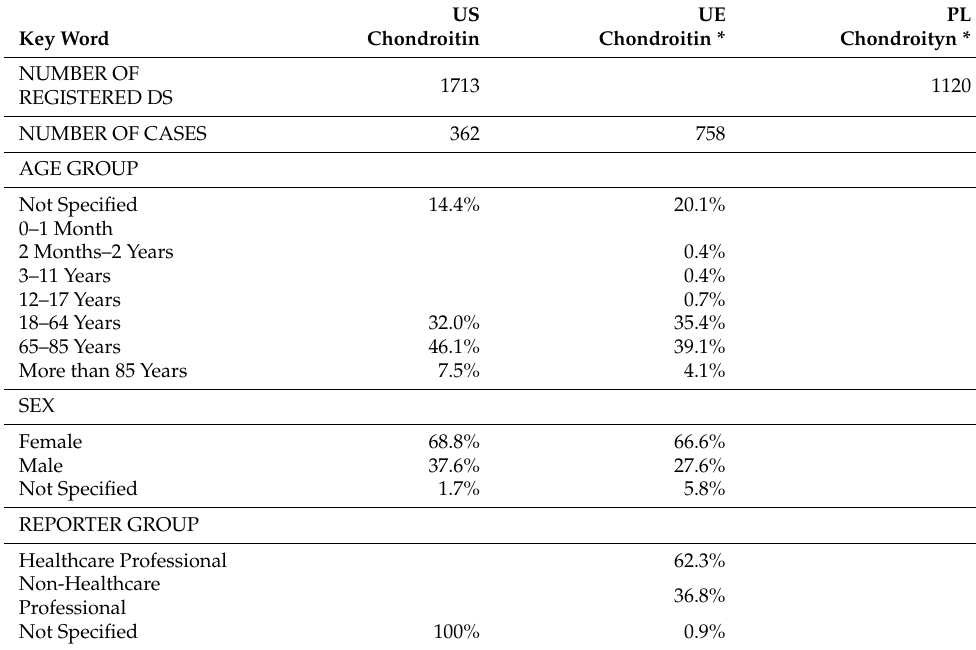
Table 7. Comparison of data on Chondroitin from different databases.